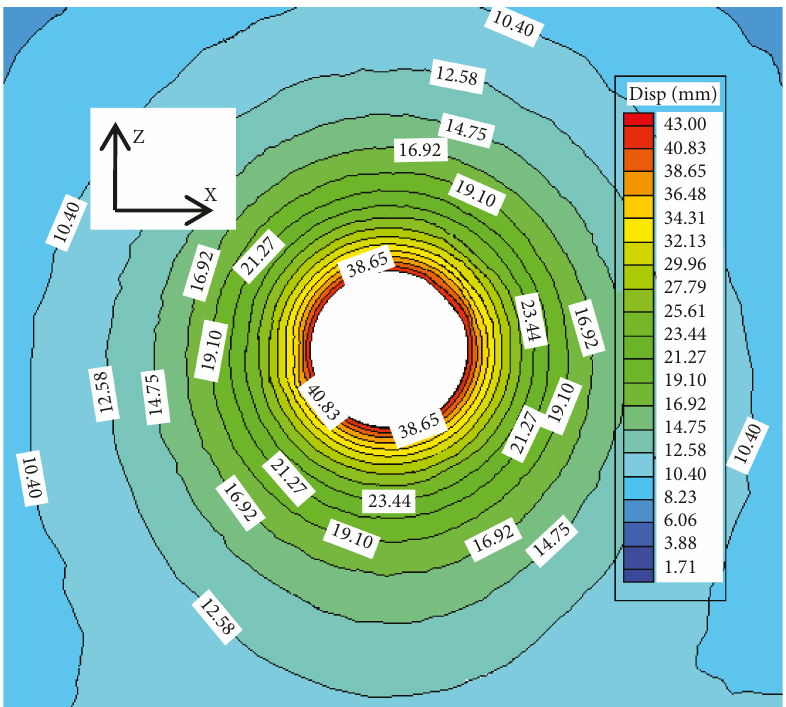
Figure 20: Resultant displacement of section B-B.